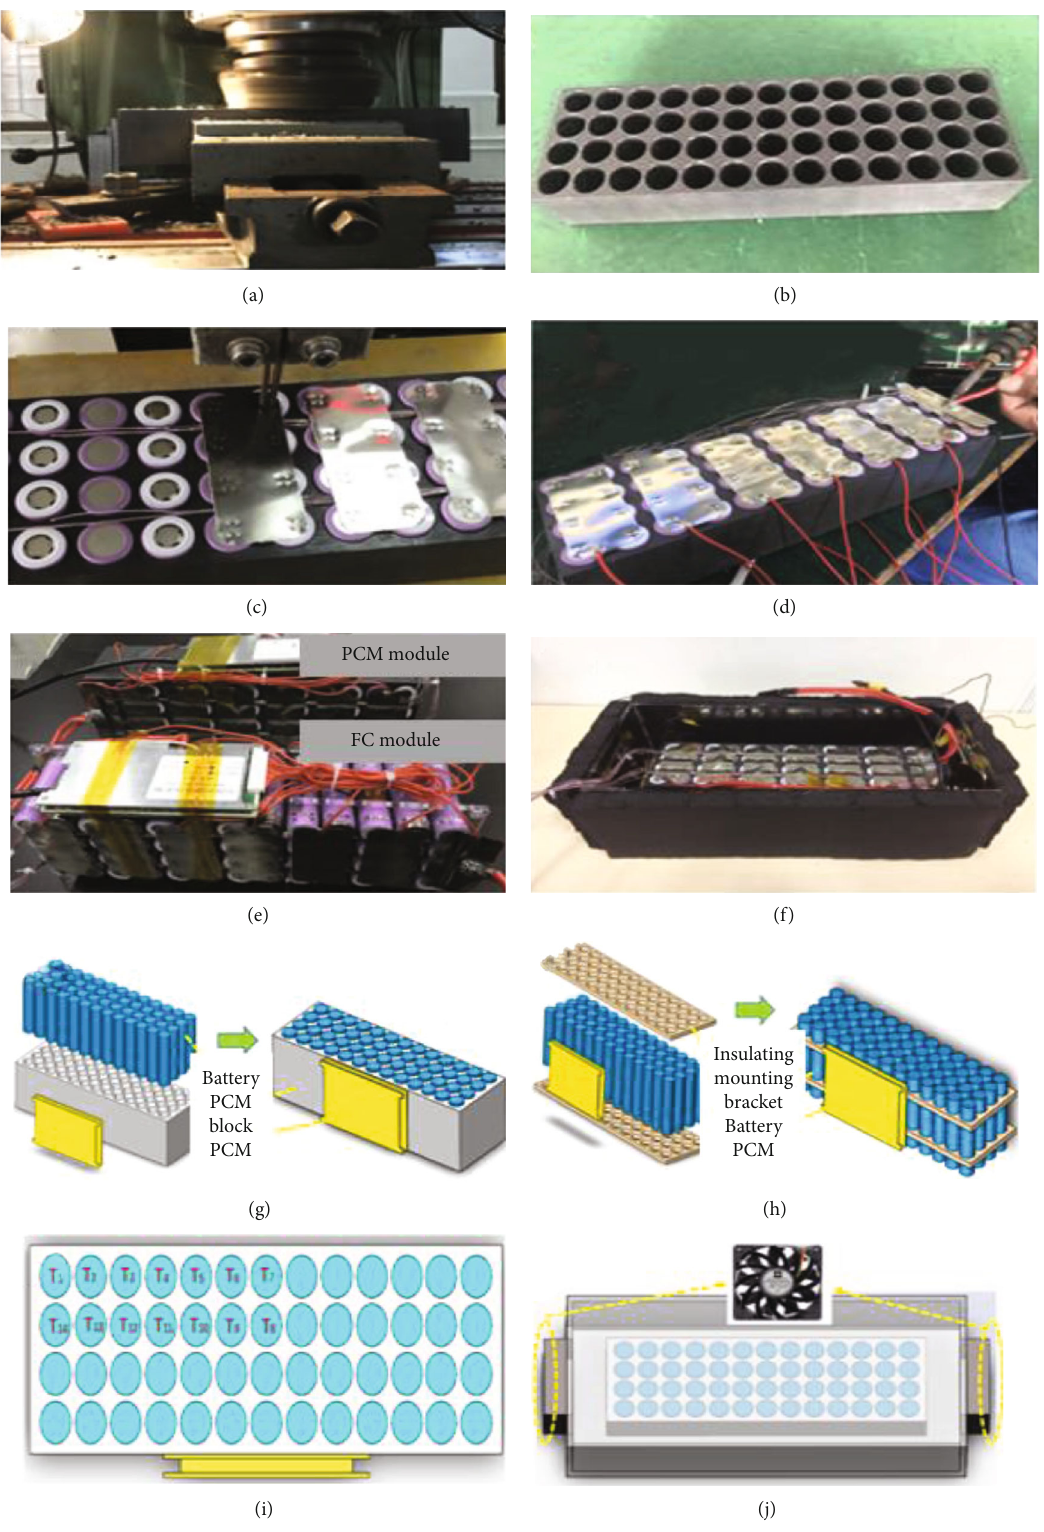
Figure 2: Schemes of the assembly process of the power battery modules and the speci fi c design